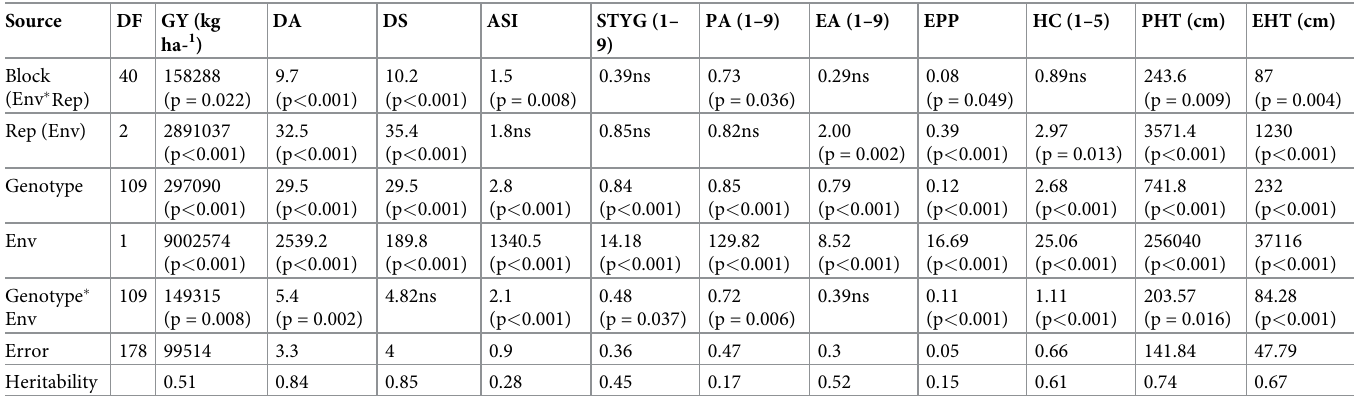
Table 1. Mean squares and heritability estimates of the inbred lines under LN stress.